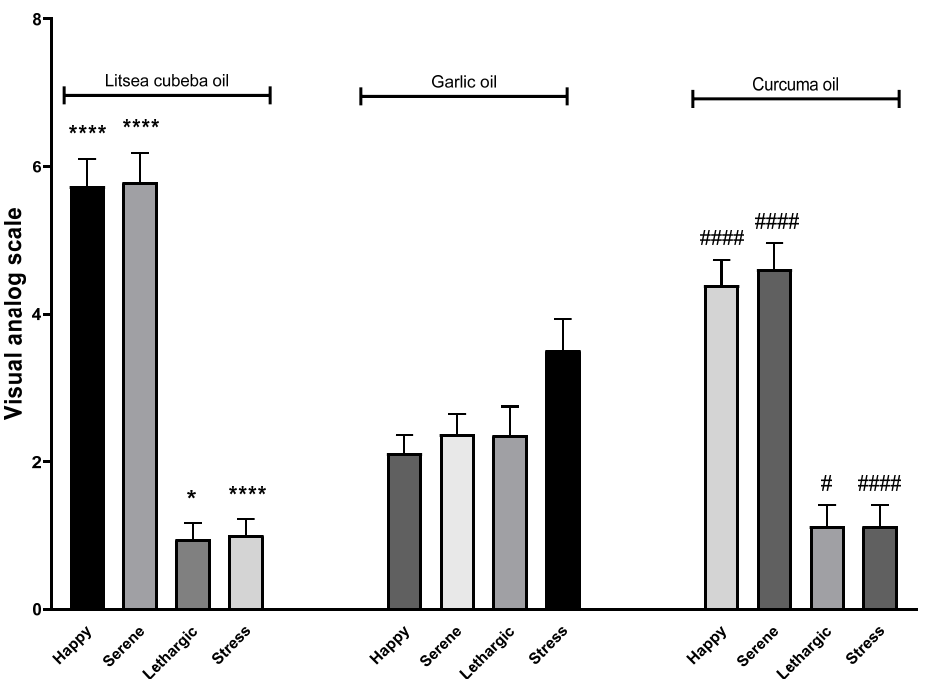
Figure 11. Effects of Litsea cubeba , garlic, and Curcuma longa oil inhalations on positive and negative moods; happy, serene, lethargic, and stress. p value compared Litsea cubeba oil with garlic oil: ns ≥ 0.05, * < 0.05, and **** < 0.0001. p value compared Curcuma longa oil with garlic oil: not significant (ns) ≥ 0.05, # < 0.05, and #### < 0.0001.